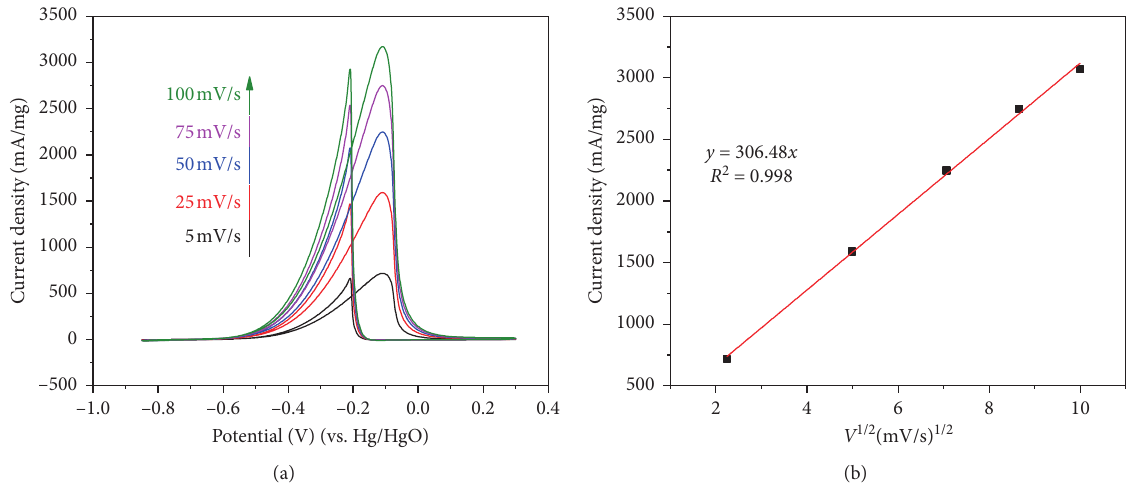
Figure 6: (a) CV curves of PdAg-acac-4 NP-modified GCEs at different scan rates. (b) Corresponding plot of the forward peak current versus the square root of the scan rate.